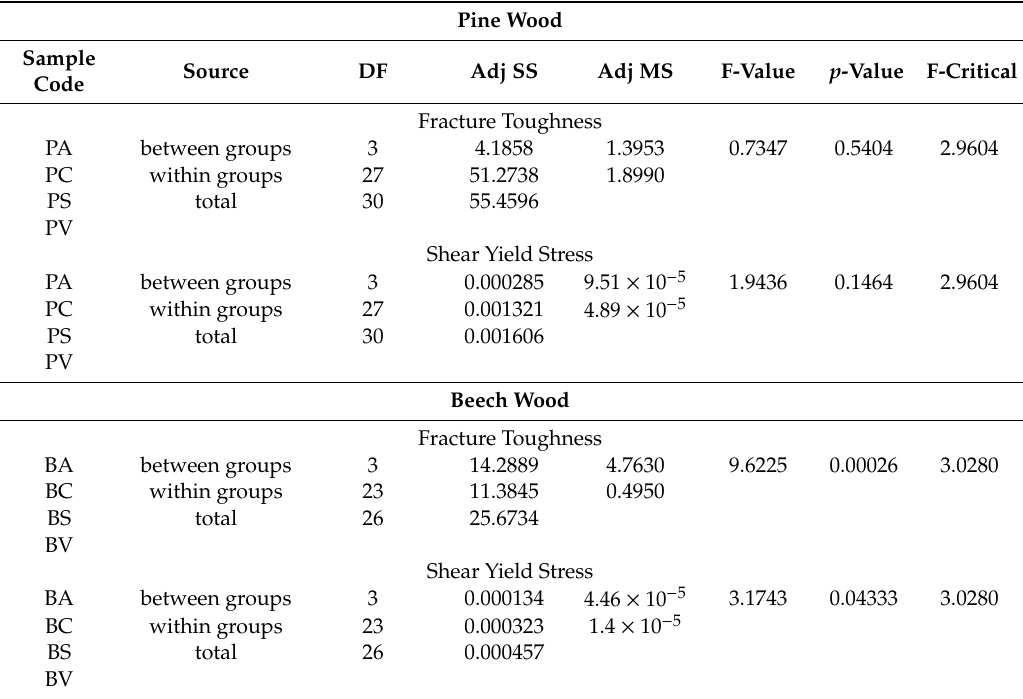
Table 4. Significance of di ff erences between fracture toughness and shear yield stress of pine and beech samples dried with di ff erent methods (ANOVA) ( α =